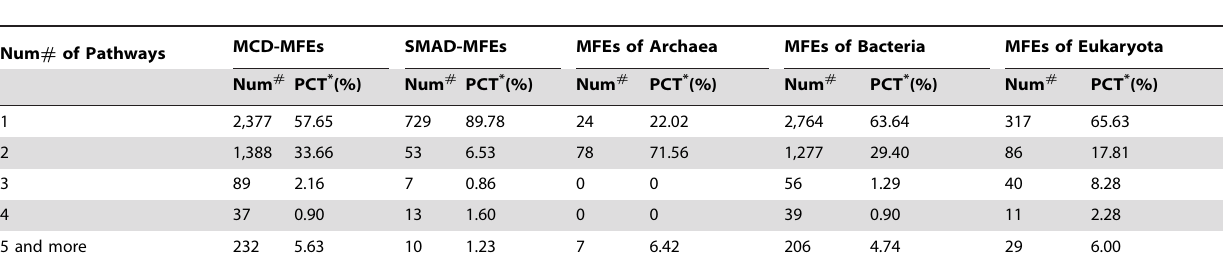
Table 2. The statistics of MFEs by number of KEGG biological pathways they are involved in.